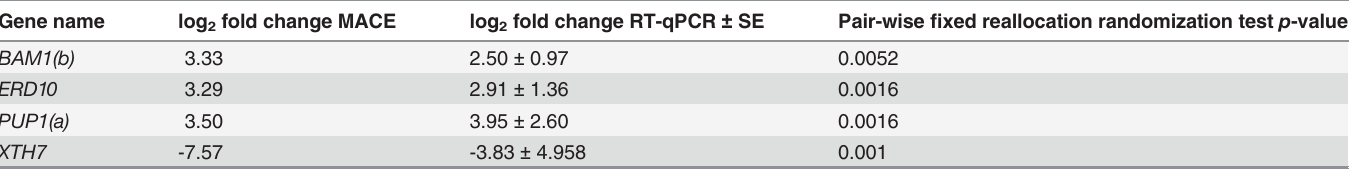
Table 4. Log 2 fold changes of the four specifically amplified genes for validation resulting from the MACE analysis and RT-qPCR (calculated using REST with correction of amplification